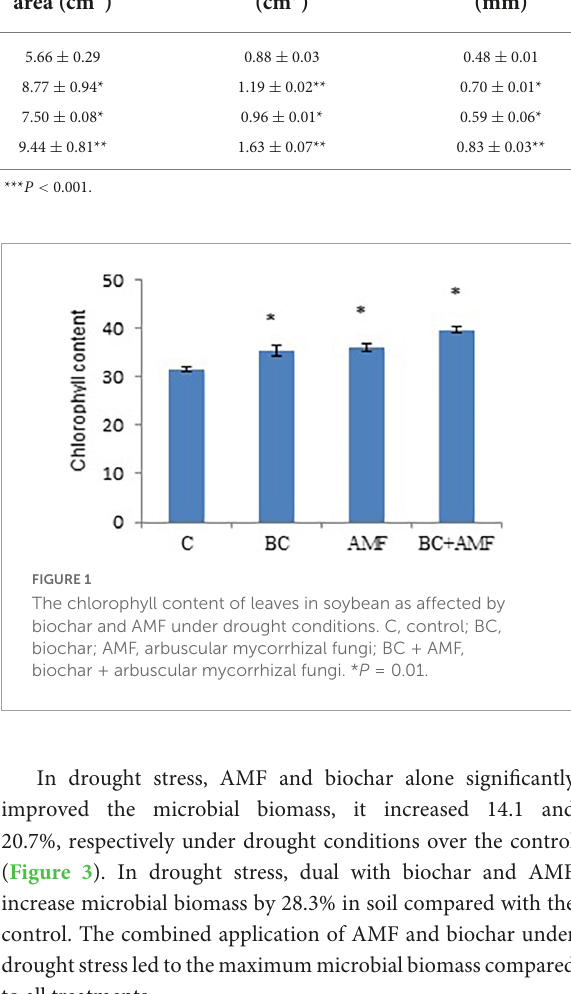
TABLE 2 Root morphological traits in soybean as affected by biochar and AMF under drought condition. Treatments